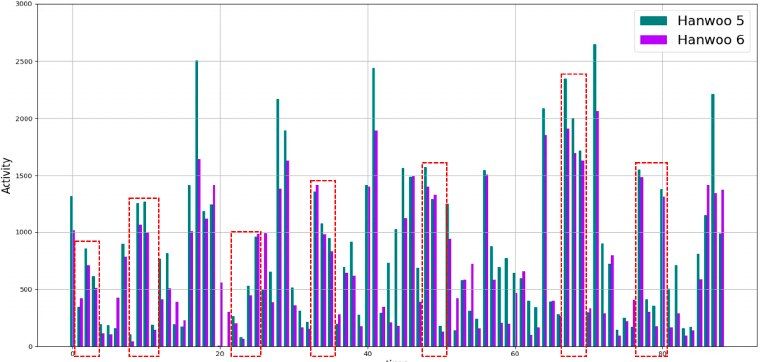
Figure 12. Changes in activities of estrous Hanwoo (No. 5) and non-estrous Hanwoo (No. 6) in Group B.